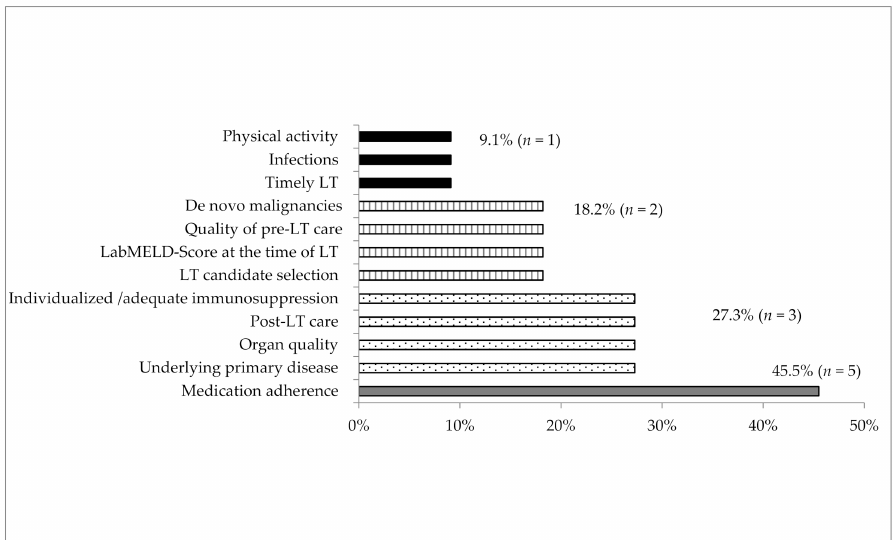
Figure 1. Responses to the open-ended question: “Which factors have the most likely influence on the patient outcome in the post-transplant setting?” (11 centers; multiple answers